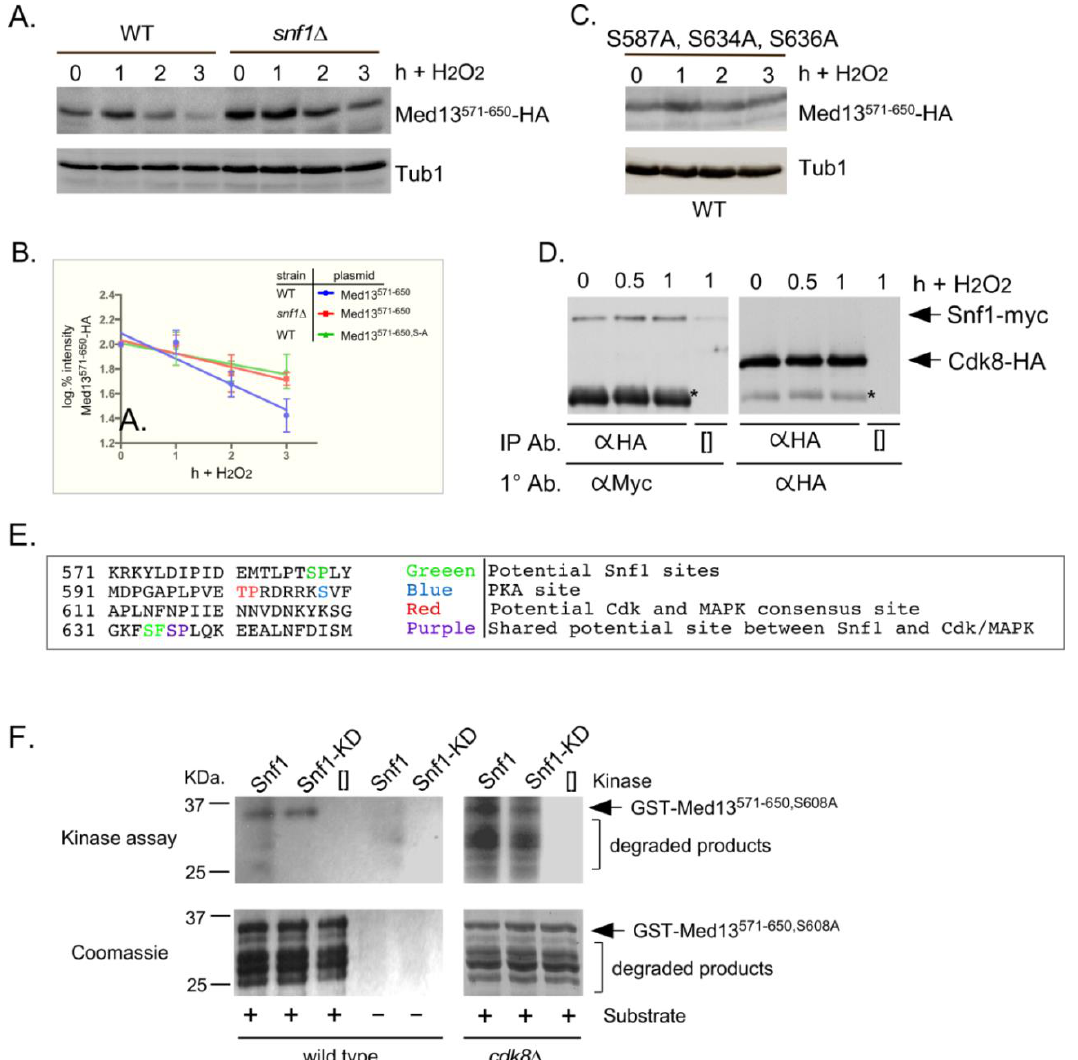
FIGURE 5: Snf1 phosphorylates degron 571-650 . (A) Mid-log wild-type (RSY10) or snf1 ∆ cultures (RSY202) harboring degron 571-650 (pDS15) were subjected to an H 2 O 2 timecourse experiment and protein extracts analyzed by Western blot. Tub1 levels were used as loading controls. (B) Degradation kinetics of degron 571-650 shown in A and C. Values represent averages ± SD from a total of at three Western blots from independ- ent experiments. (C) As in A except that degron 571-650,S587A, S634A, S636A (pDS56) was analyzed in wild-type cells. (D) Co-immunoprecipitation analysis of Snf1-myc and Cdk8-HA. Mid log wild-type cells harboring Snf1-myc and Cdk8-HA on single copy plasmids were treated with 0.4 mM H 2 O 2 for the timepoints shown. Protein extracts were immunoprecipitated with anti-HA, separated by SDS-PAGE Western analysis and the membrane probed with the antibodies shown. [] represents no IP antibody and the asterisk represents the heavy chain. See Fig. S3C for vector control. (E) Potential phospho-sites in Med13 571-650 . (F) Upper panels: Kinase assays using Snf1 and Snf1 K84R -myc (kinase dead) im- munoprecipitated from yeast protein extracts prepared from either wild type (left panel) or cdk8 ∆ cells (right panel) and Med13-degron 571-650 (GST-Med13 571-906,S608A purified from E. coli ) as the substrate. The reactions were separated by SDS PAGE and subject to autoradiography. Lower panels: Coomassie stained gels showing the input used in the kinase